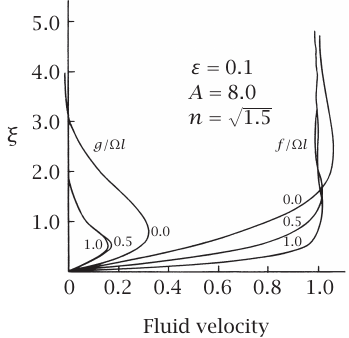
Figure 3.3 . Variations of f/ Ω l and g/ Ω l for different values of suction pa- rameter S in presence of variable suction A